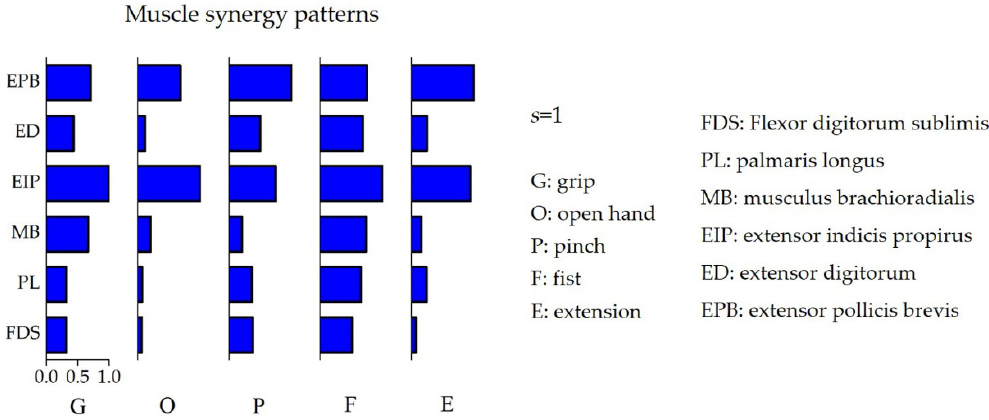
Figure 6. The muscle synergy patterns according to the gestures grip (G), open hand (O), pinch (P), fist (F), and extension (E). The optimal number of synergies was set as s = 1 for all five of the gestures. The blue colored bars indicate the synergy matrix ( W ), which shows the extent of contribution changes between the six muscles when performing the corresponding gesture.